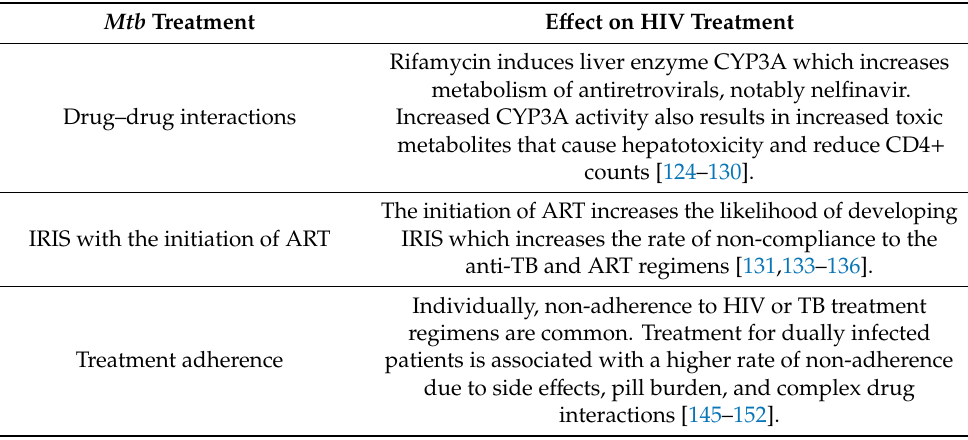
Table 2. Summary of Mtb treatment factors that can exacerbate HIV